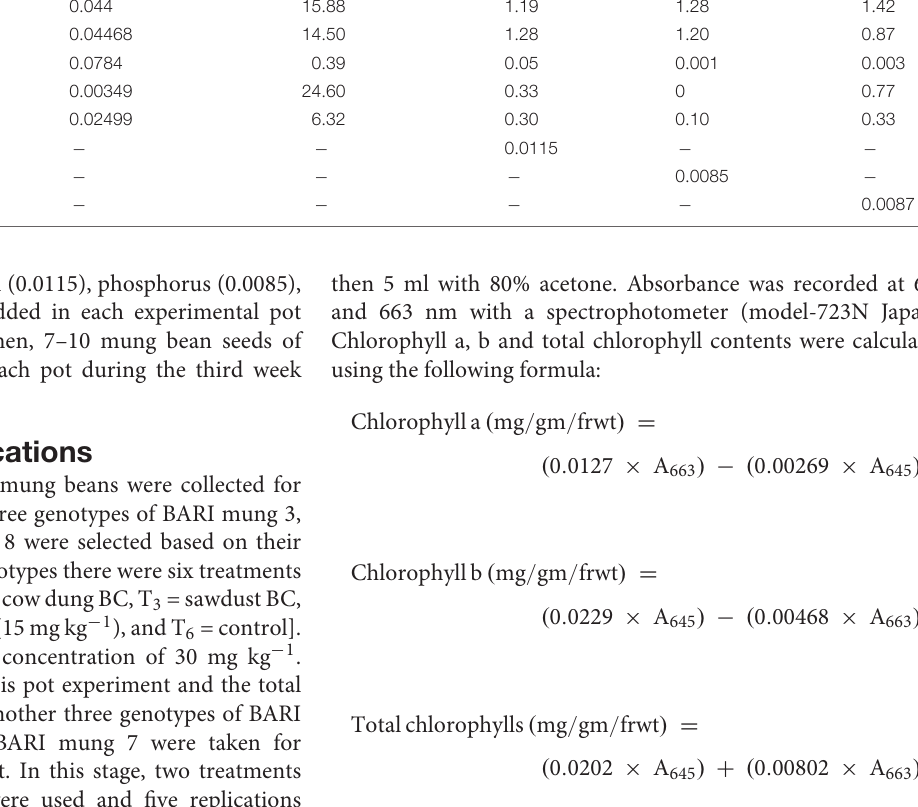
TABLE 1 | Total arsenic (As), percentage of OC, N, P, and K in background soil, Trichoderma-enriched biofertilizer, different biochars and applied fertilizers. Samples Total arsenic (As) in mg/kg % Organic carbon (OC) % Nitrogen (N) % Phosphorus (P) % Potassium